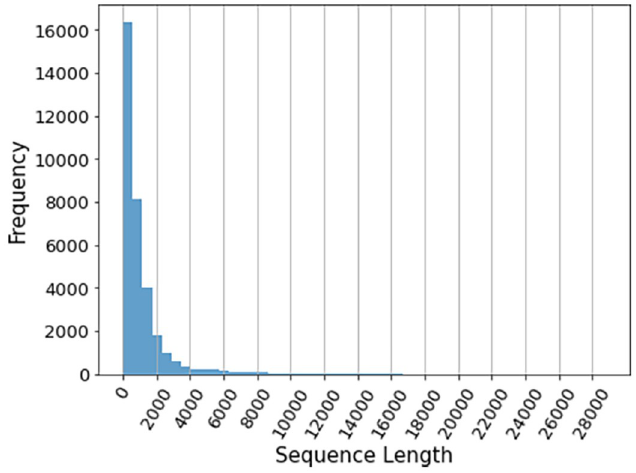
Fig 4. Distribution of sequence length of 33,740 concatenated clinical notes after tokenization using PubMedBERT model. The notes were taken within 24 hours after admission.